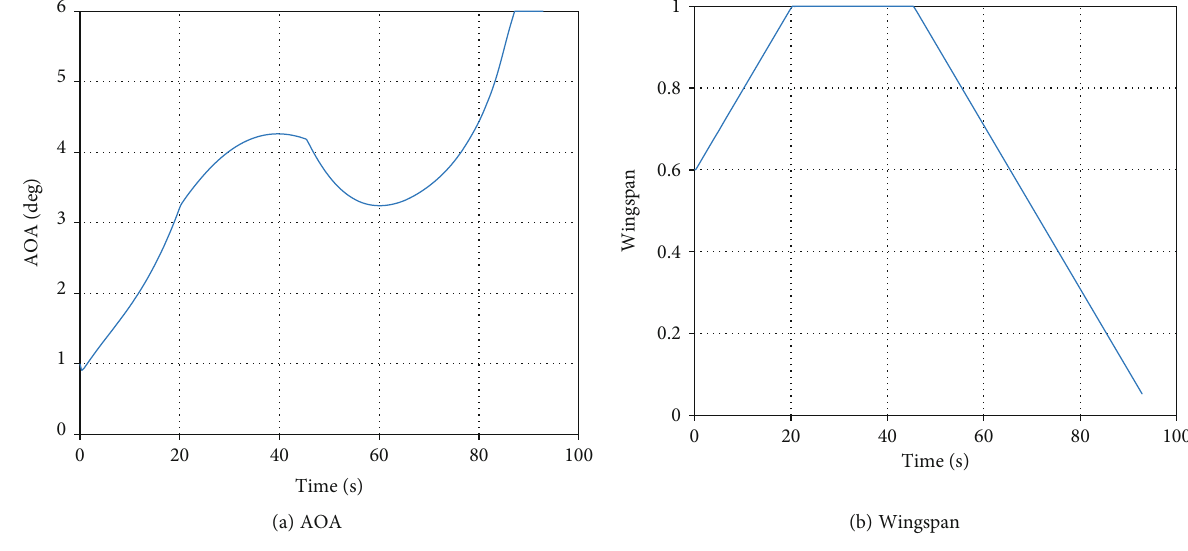
Figure 3: The time history of